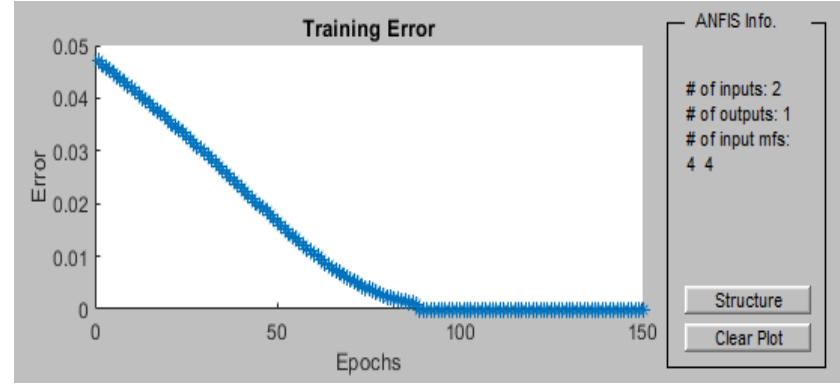
Figure 14. Trend of errors of the trained fuzzy system.